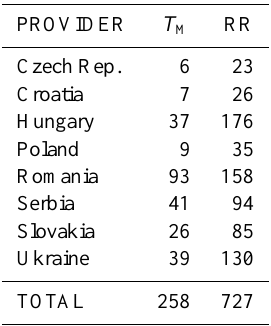
Table 1. Number of mean temperature ( T M ) and precipitation (RR) station records used to compute the